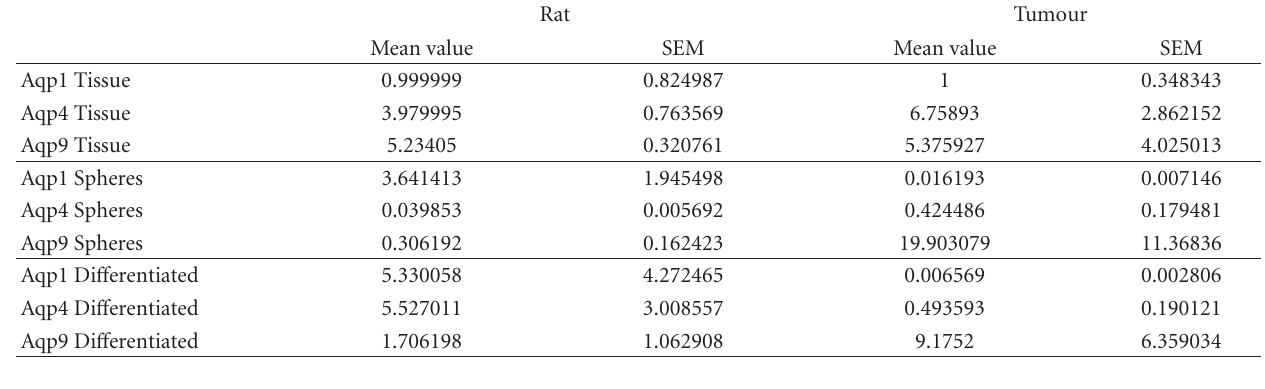
Table 1: Relative mRNA expression of Aquaporins 1, 4, and 9 in normal rat brain and human brain tumour-derived tissue, stem cells, and di ff erentiated cells. Values are based on setting the ratio of Aqp1/18S in tissue to 1.